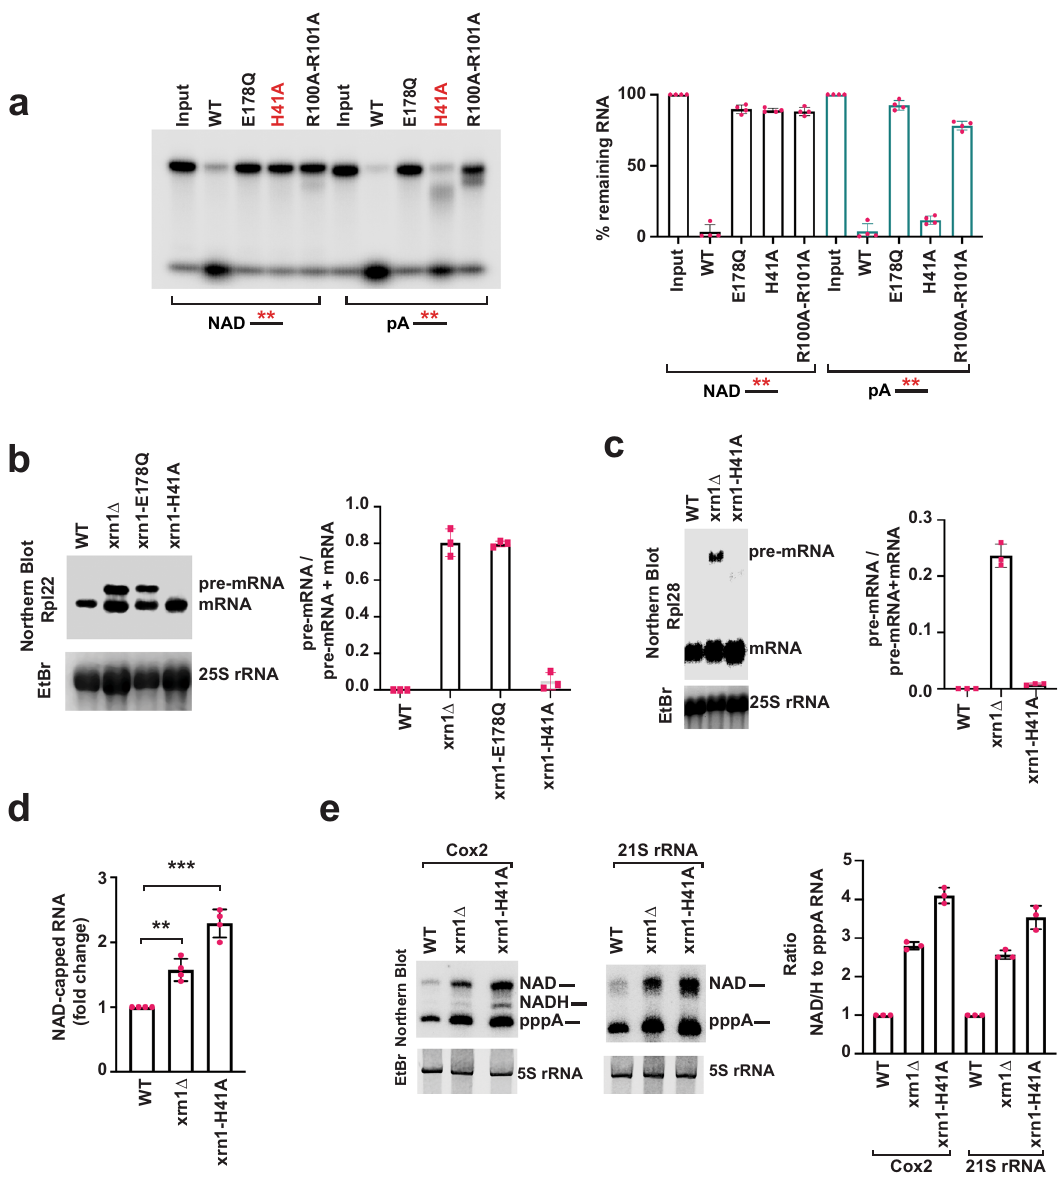
Fig. 4 A conserved histidine residue in the catalytic pocket of Xrn1 is indispensable for NAD-capped RNA hydrolysis. Xrn1 mutational screen revealed that H41 is indispensable for NAD-capped RNA hydrolysis. a 30 nM recombinant WT or mutated Xrn1 from K. lactis was incubated with uniformly 32 P-labeled 5 ′ -monophosphate or NAD-capped RNA. The products were resolved by 15% 7 M urea PAGE gel. Quantitation from four independent experiments are presented on the right with the percent of full length RNA remaining. Error bars represent ±SD. b Northern Blot for Rpl22 mRNA in WT, xrn1 Δ , xrn1 -E178Q, and xrn1 -H41A knock-in mutant is shown. Quantitation from three independent experiments are presented on the right with the mean ratio of Rpl22 pre-mRNA over total (pre-mRNA + mRNA). Error bars represent ±SD. c Northern Blot for Rpl28 mRNA in WT, xrn1 Δ and xrn1-H41A knock-in mutant is shown. Quantitation from three independent experiments are presented on the right with the mean ratio of RPL28 pre-mRNA over total (pre- mRNA + mRNA) for the WT, xrn1 Δ and xrn1 -H41A. Error bars represent ±SD. d Total RNAs from WT, xrn1 Δ , xrn1 -H41A strains were subjected to the NAD- capQ assay to detect total level of cellular NAD-capped RNAs. Average from n = 4 independent experiments are shown with error bars denoting ±SEM. Statistical signi fi cance level was calculated by one-way ANOVA ( F = 18.30, df = 2.209, p < 0.0001) with a Dunnett ’ s multiple comparison post hoc test, ** p = 0.0036, *** p = 0.00013. e Northern Blot analysis of DNAzyme-generated 5 ′ -end-containing subfragments of Cox2 and 21S rRNA from WT, xrn1 Δ and xrn1- H41A grown in YPD (fermentation) media. Quantitation from three independent experiments with error bars representing ±SD are shown on the right. Source data are provided in Source Data